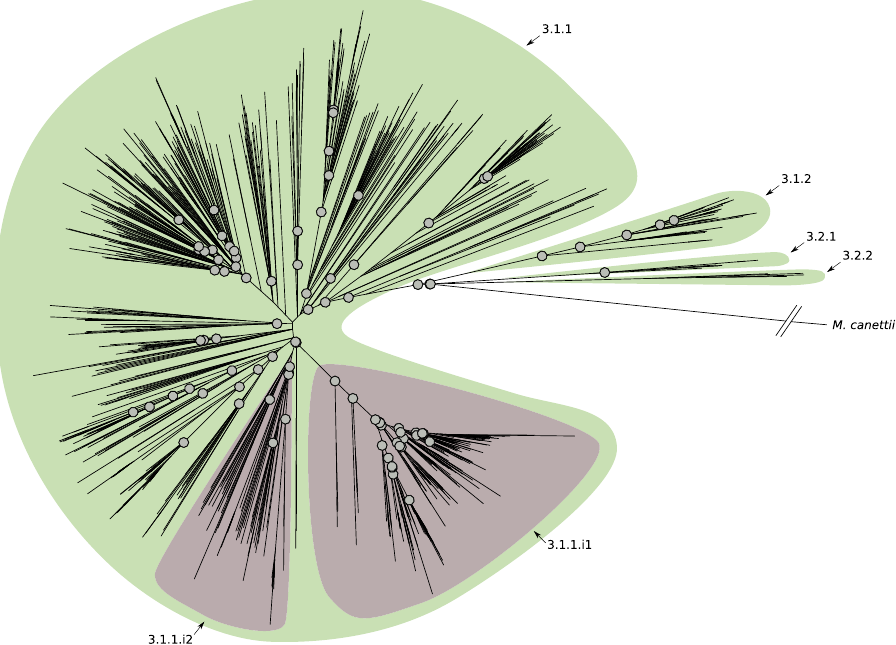
Fig. 2 Phylogenetic tree reconstruction of lineage 3 (binary tree). Gray circles de fi ne splits where the F ST ( fi xation index) calculated using the descendants of the two children nodes is greater than 0.33. The sub-lineages are de fi ned by colored areas (green: sub-lineages described here; purple: internal sub-lineages). Source data are provided as a Source Data fi le.